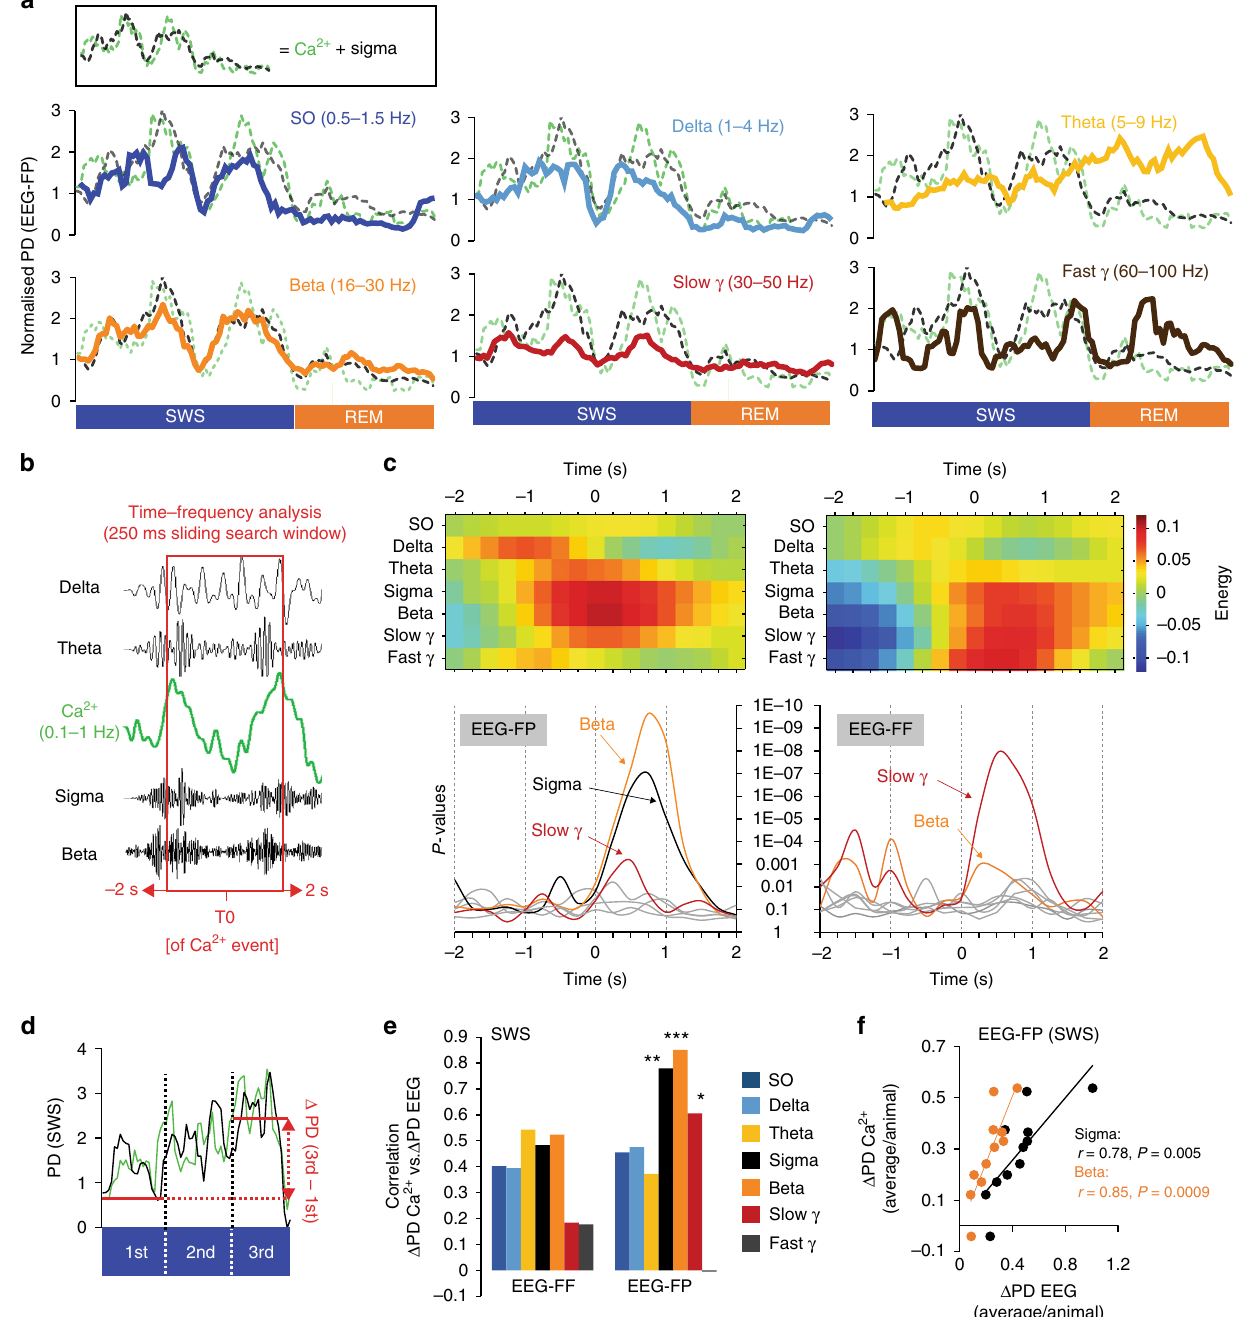
Fig. 4 Changes in Ca 2+ activity in population of dendrites correlates with local changes in sigma – beta power during SWS. a Examples of PD time course for different frequency bands from the EEG surrounding the Ca 2+ imaging site (i.e., EEG-FP). Traces are plotted against the sigma+dendritic Ca 2+ PD trendlines ( dotted lines , inset ). b Illustration of the cross-correlation time – frequency analysis (see Methods). c Time – frequency analysis for dendritic recordings. Results for local (FP, left ) and distant (FF, right ) EEGs are represented. Energy heat maps ( upper graphs ) with corresponding P -values ( bottom graphs ) for a ± 2 s cross-correlation time window (see Supplementary Fig. 6b for L2/3 results). d Illustration of the Δ PD (PD 3rd − PD 1st) calculation. e Correlation coef fi cient between the mean (across SWS episodes in each animal) Ca 2+ and EEG frequency bands Δ PDs ( n = 11). Results are shown separately for frontal and parietal EEGs. * P < 0.05, ** P < 0.01 and *** P < 0.001, Pearson ’ s correlation. f Corresponding scatter plots for sigma and beta frequency bands for EEG- FP (values represent individual animals). Correlations were not signi fi cant for frontal EEG (vs. EEG-FF, sigma: r = 0.48, P = 0.13; beta: r = 0.52, P =